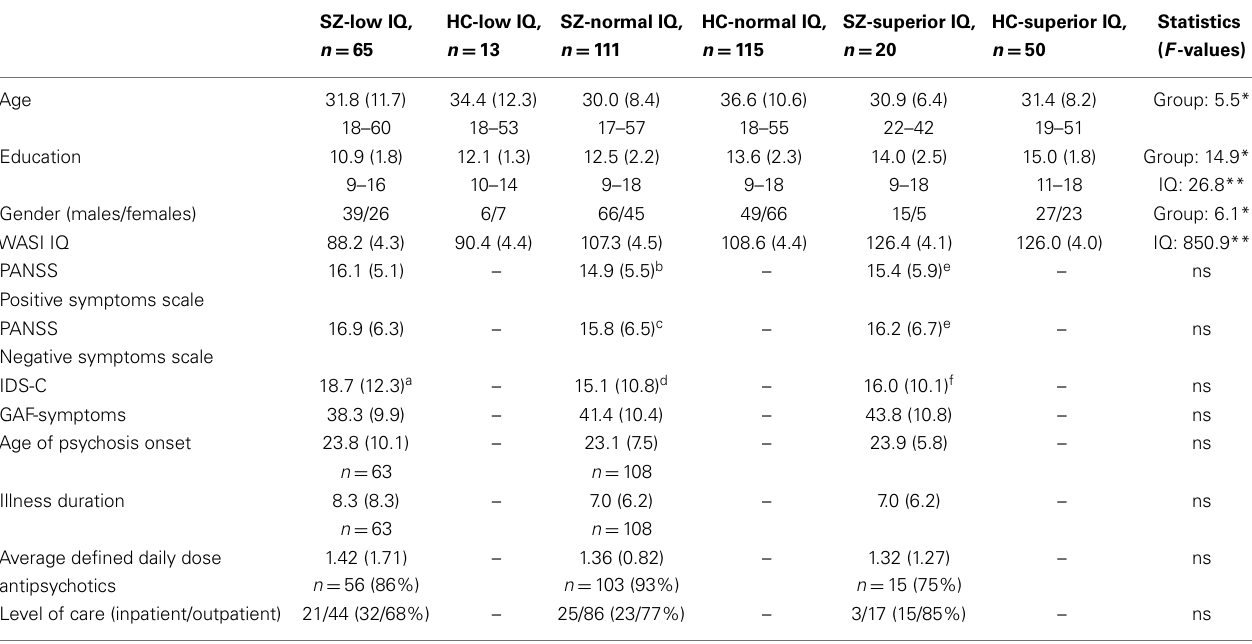
Table 1 | Demographic characteristics in schizophrenia and healthy participant groups and clinical characteristics in participants with schizophrenia